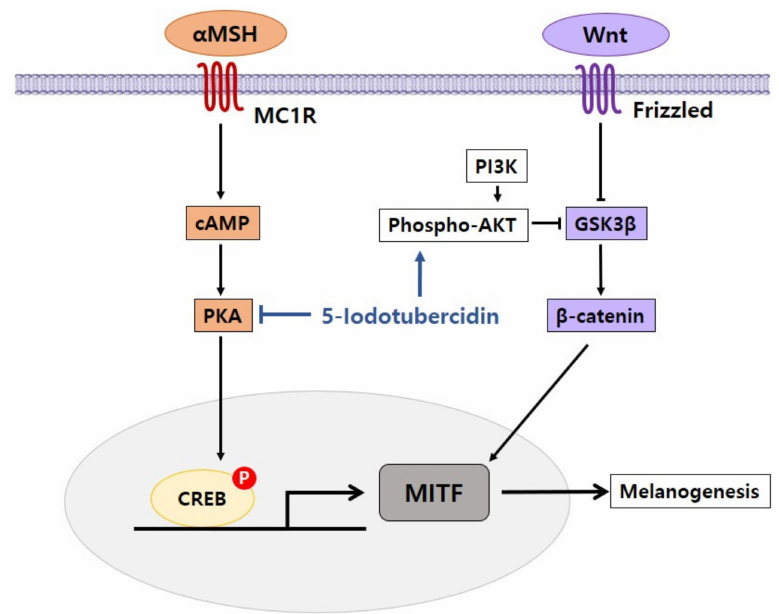
Figure 5. Proposed mechanism of 5-iodotubercidin in inhibiting effects of pigmentation. 5- Iodotubercidin inhibits melanogenesis by inhibiting cAMP/PKA and activating